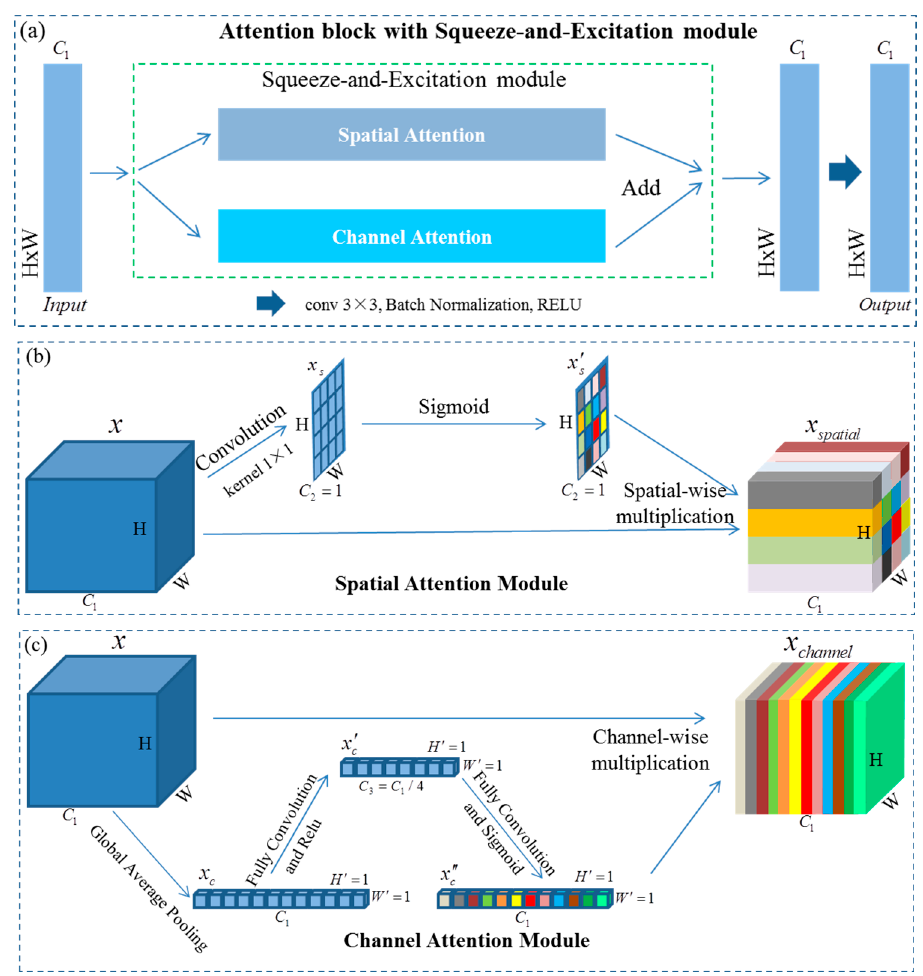
Figure 3. Architecture of attention block with squeeze-and-excitation (SE) module. ( a ) Overall structure of the attention block; ( b ) structure of spatial attention module; ( c ) structure of channel attention module. H, W, and C represent the height, width, and channel of the feature map, respectively.